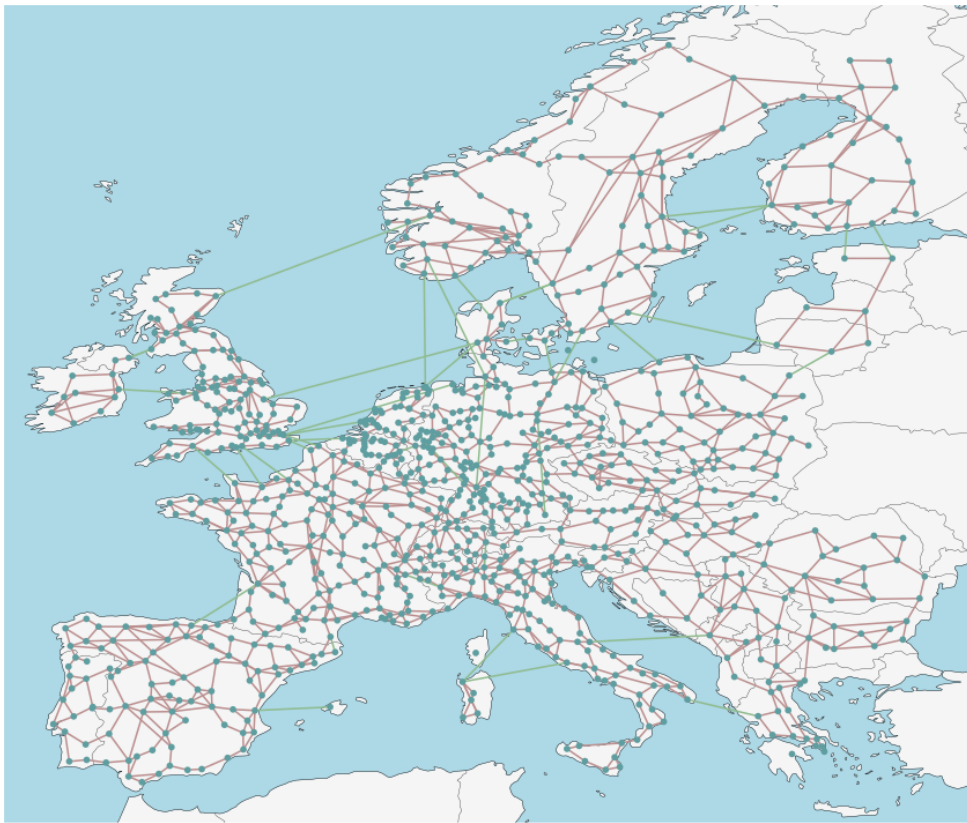
Figure 2. Nodal network consisting of 1010 nodes obtained using PyPSA-Eur